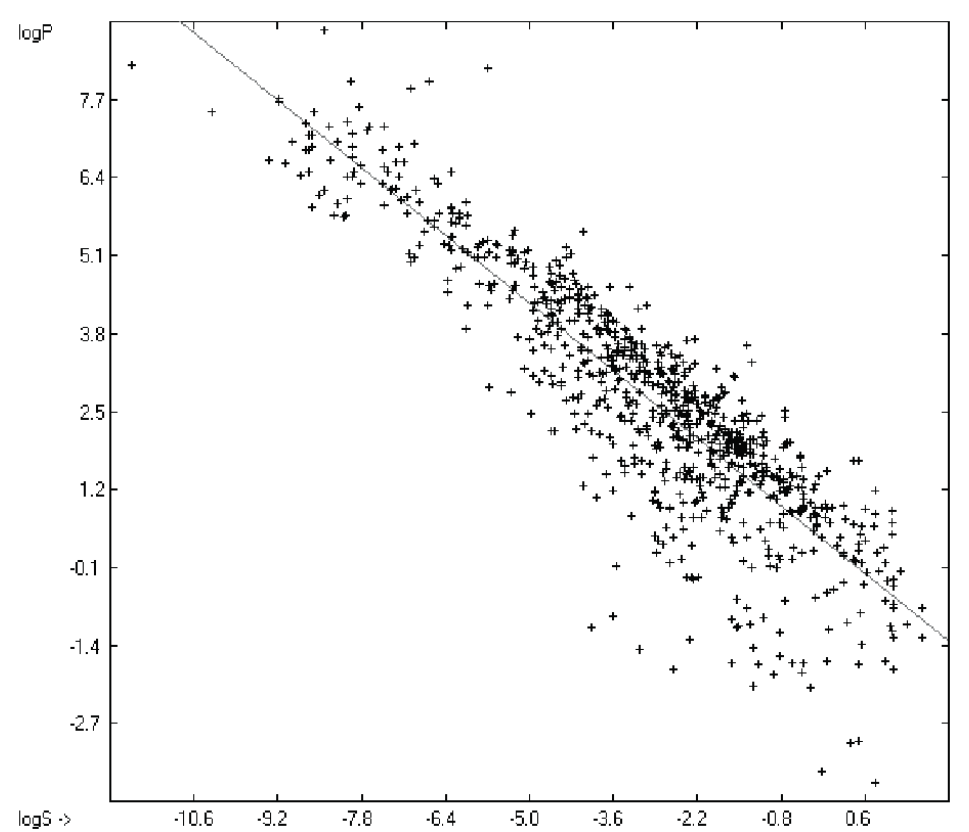
Figure 7. Correlation of logP with logS (N = 839, R 2 =